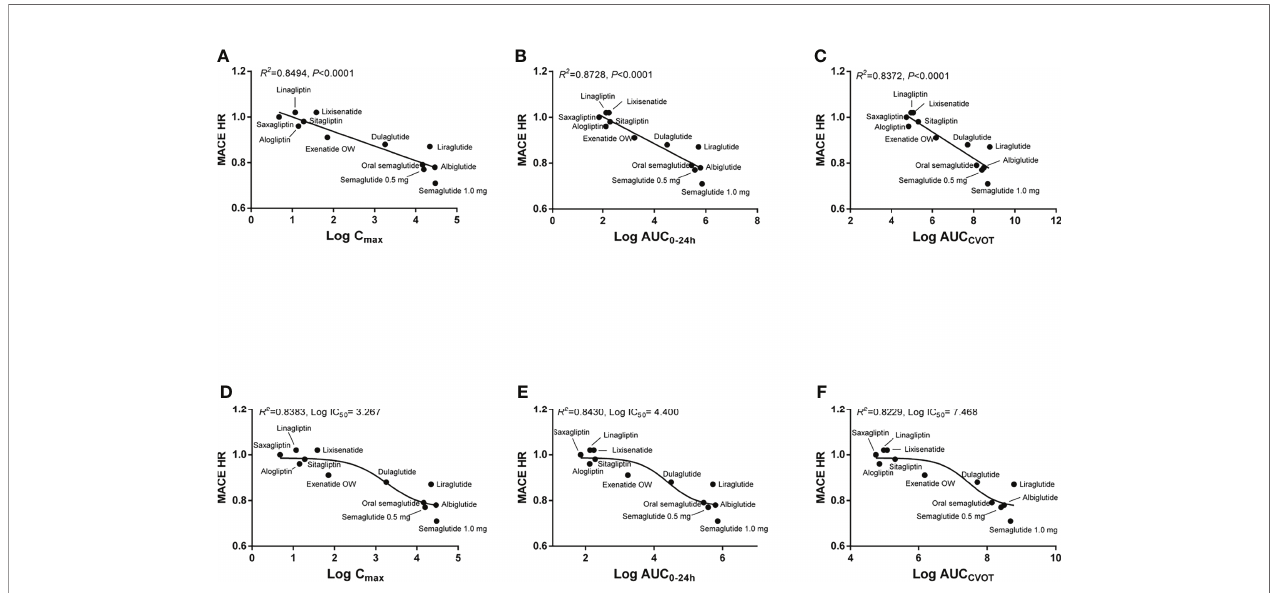
FIGURE 1 | Correlation between drug exposure and MACE HR. (A) Linear regression analysis between log C max and MACE HR; (B) Linear regression analysis between log AUC